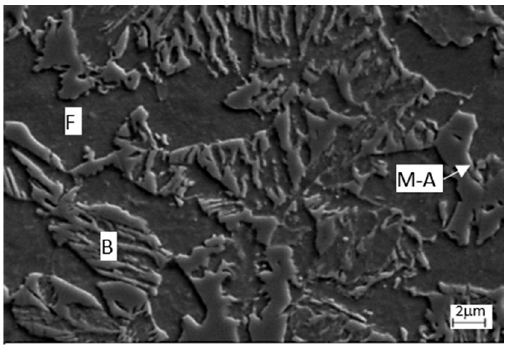
Figure 9. Heat treatment parameters: Soaking 850 °C/100 s, cooling rate 50 °C/s, bainitic hold 400 °C/600 s. Ferritic-bainitic microstructure with M-A constituent.